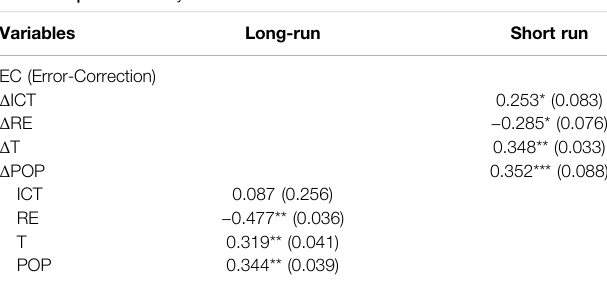
TABLE 8 | Results of dynamic fi xed effect model.